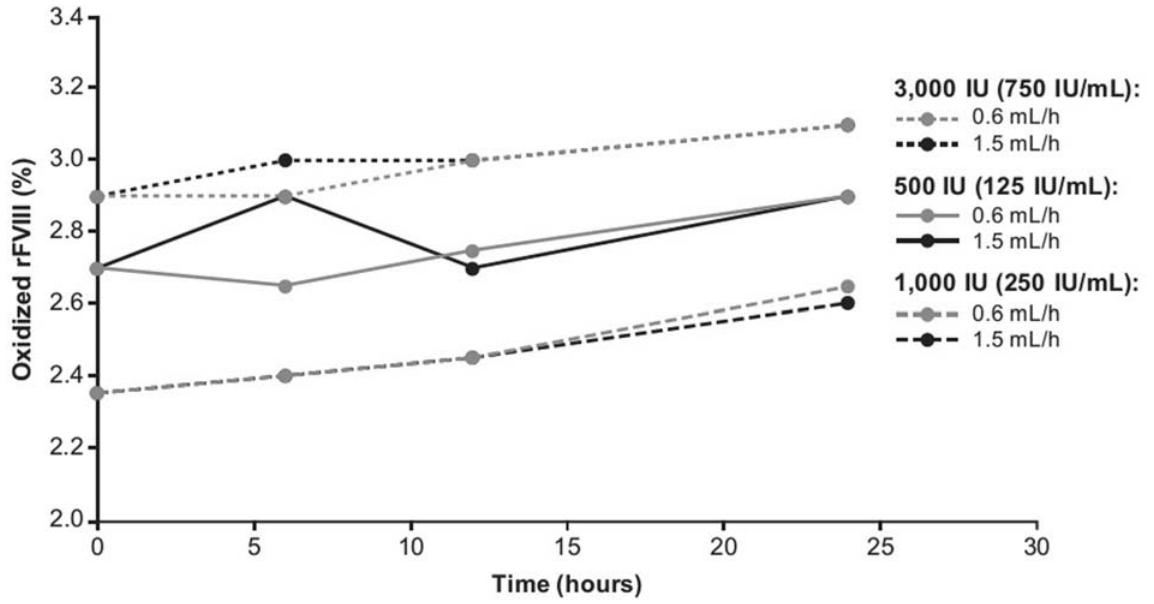
Fig. 5 Oxidized forms of turoctocog alfa were assessed during 24 hours of CI at pump speeds of 0.6 and 1.5 mL/h. The following turoctocog alfa samples were assessed: 500 IU (equating to 125 IU/mL), 1,000 IU (equating to 250 IU/mL), and 3,000 IU (equating to 750 IU/mL). CI, continuous infusion; rFVIII, recombinant factor